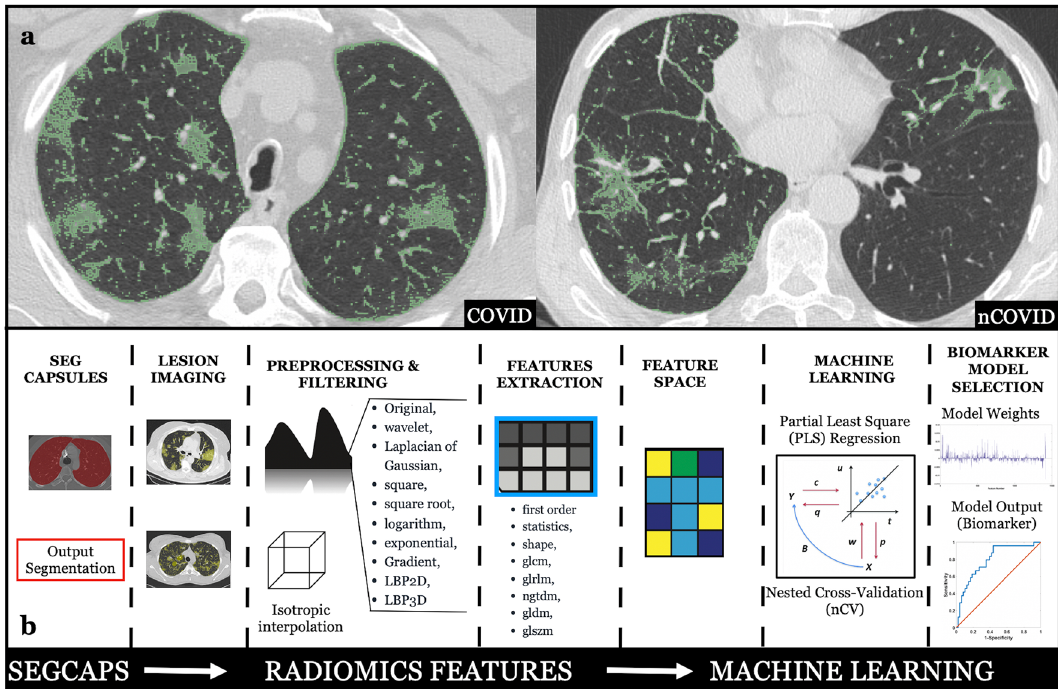
Figure 2. ( a ) Ground glass opacities segmentations of COVID and nCOVID on chest high-resolution computed tomography. ( b ) Schematic representation of the radiomics features extraction and the machine learning framework